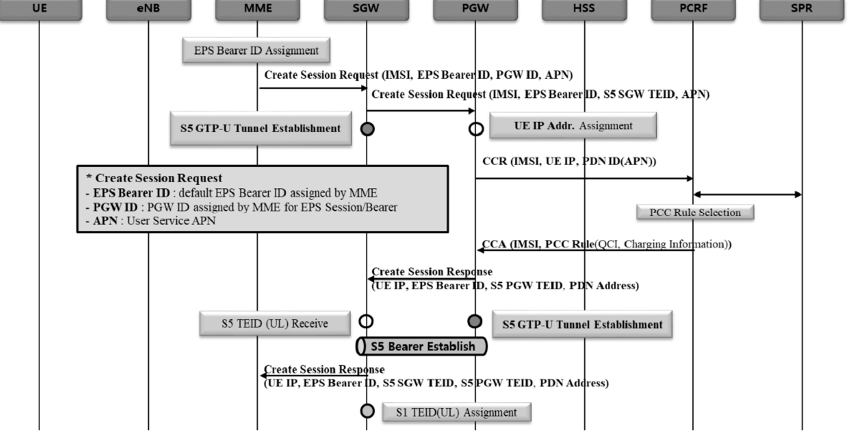
Figure 4. S5 GTP-U tunnel creation procedure.